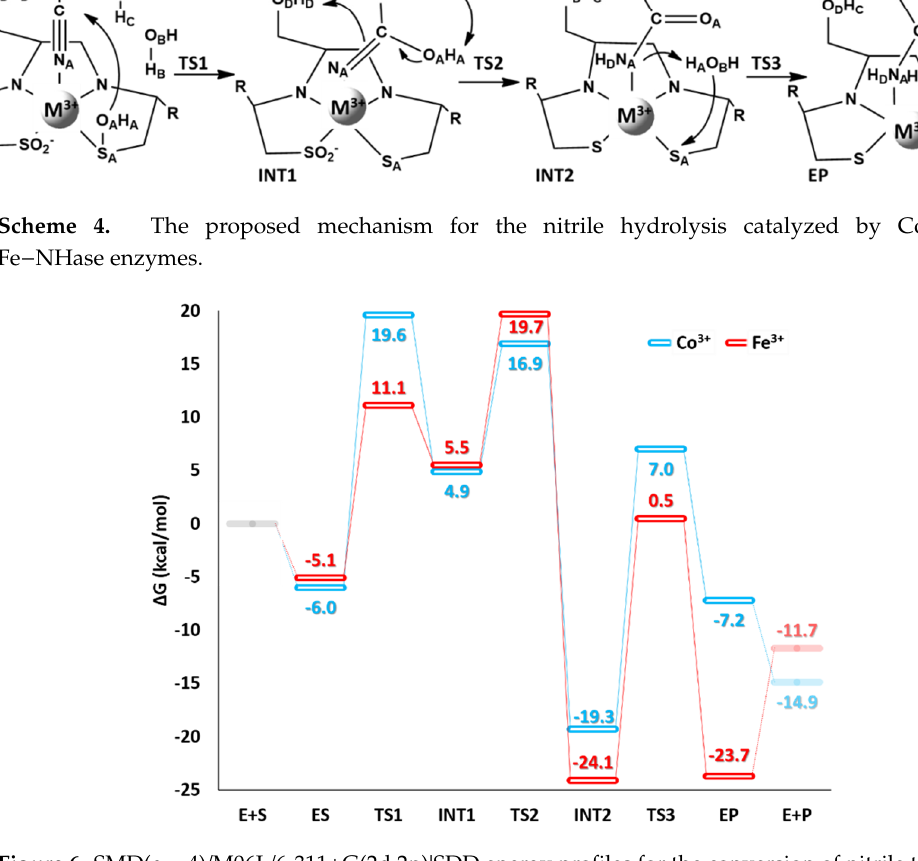
Figure 6. SMD( ε = 4)/M06L/6-311+G(2d,2p)|SDD energy profiles for the conversion of nitrile to amide catalyzed by Co 3+ - and by Fe 3+ -NHase enzymes [132].